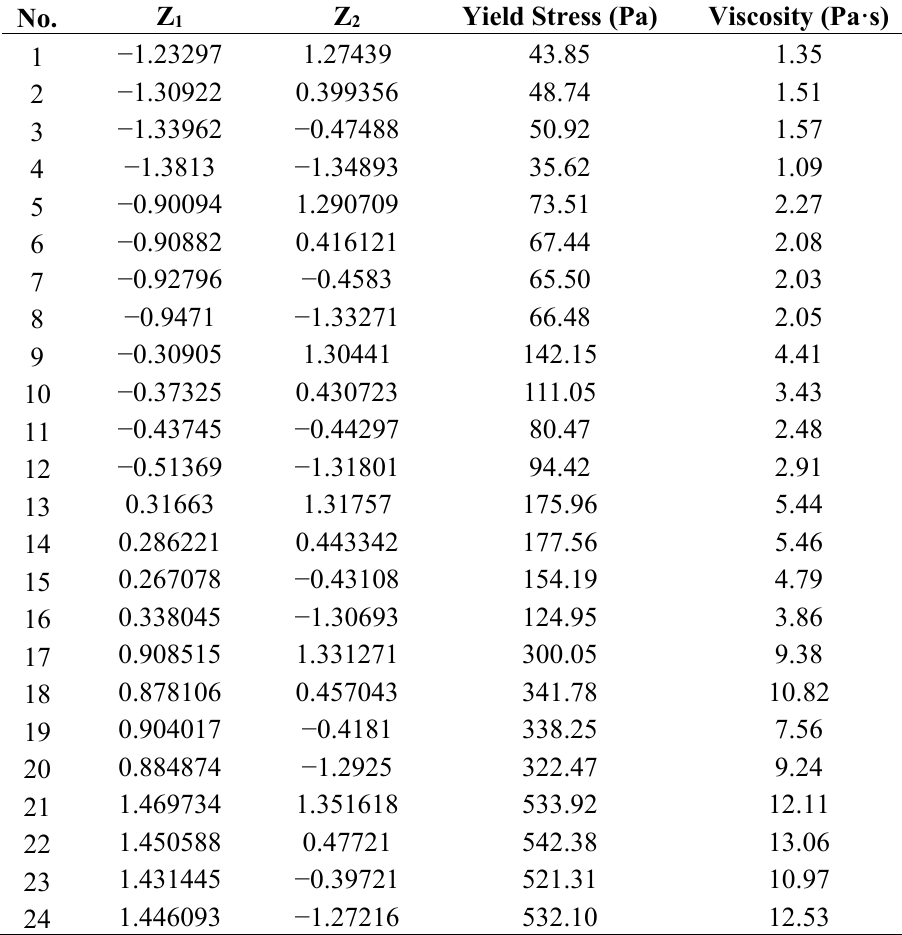
Table 10. Experimental data with the PCA